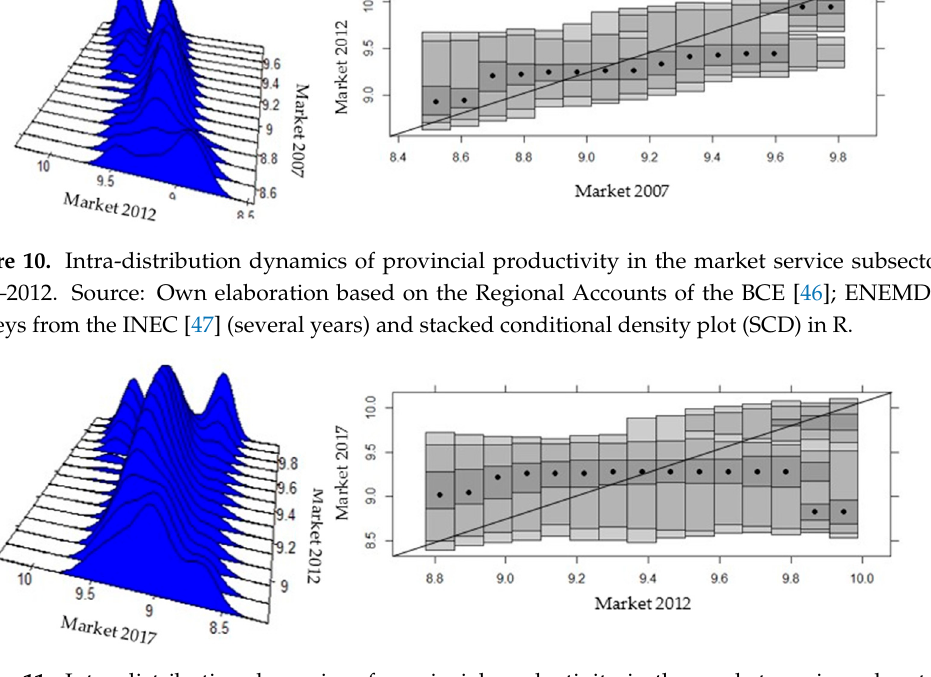
Figure 10. Intra-distribution dynamics of provincial productivity in the market service subsector, 2007–2012. Source: Own elaboration based on the Regional Accounts of the BCE [46]; ENEMDU surveys from the INEC [47] (several years) and stacked conditional density plot (SCD) in R.